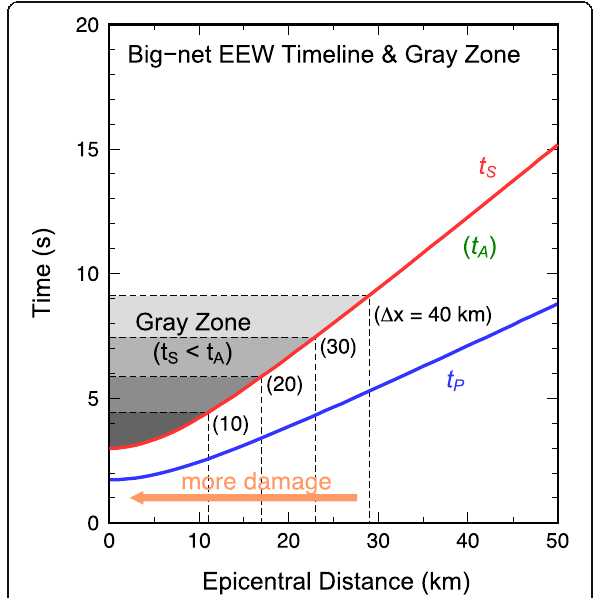
Fig. 1 Big-net EEW timeline of strong shaking arrival and gray zones for different station intervals. This example is illustrated for an event which occurs at a depth of 10 km. The vertical axis shows the elapsed time (s) from the earthquake origin time, and the horizontal axis the epicentral distance ( D , in km). The travel time curves for P- and S-waves (denoted t P and t S ) are drawn in blue and red as a function of epicentral distance, assuming 5.8 km/s for P-wave speed and 3.4 km/s for S-wave speed for the uppermost layer from the iasp91 model (Kennett and Engdahl 1991). A gray zone is the area where strong ground shaking arrives with S-wave at t S before an EEW alert at t A , (i.e., t S < t A ), and its size depends on the network station interval ( Δ x) and system processing time. Here, gray zones are shown in different shades for different station spacings, Δ x = 10, 20, 30, and 40 km, assuming the system processing time of 2 s after P-wave detection at three or more stations. The maximum D s of the corresponding gray zones are ~ 11 km, ~ 17 km, ~ 23 km, and ~ 29 km, respectively. Outside gray zones, there is a warning time of t S - t A (> 0 s). The further the site is from the epicenter, the longer the warning time is. On the other hand, the ground shaking is stronger and more damage may be caused in the gray zone than outside the